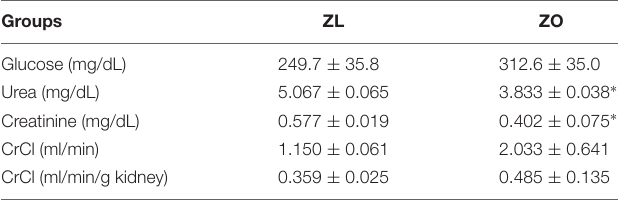
TABLE 3 | Plasma variables in male Zucker lean (ZL) and obese (ZO) rats at 8 months old. Groups